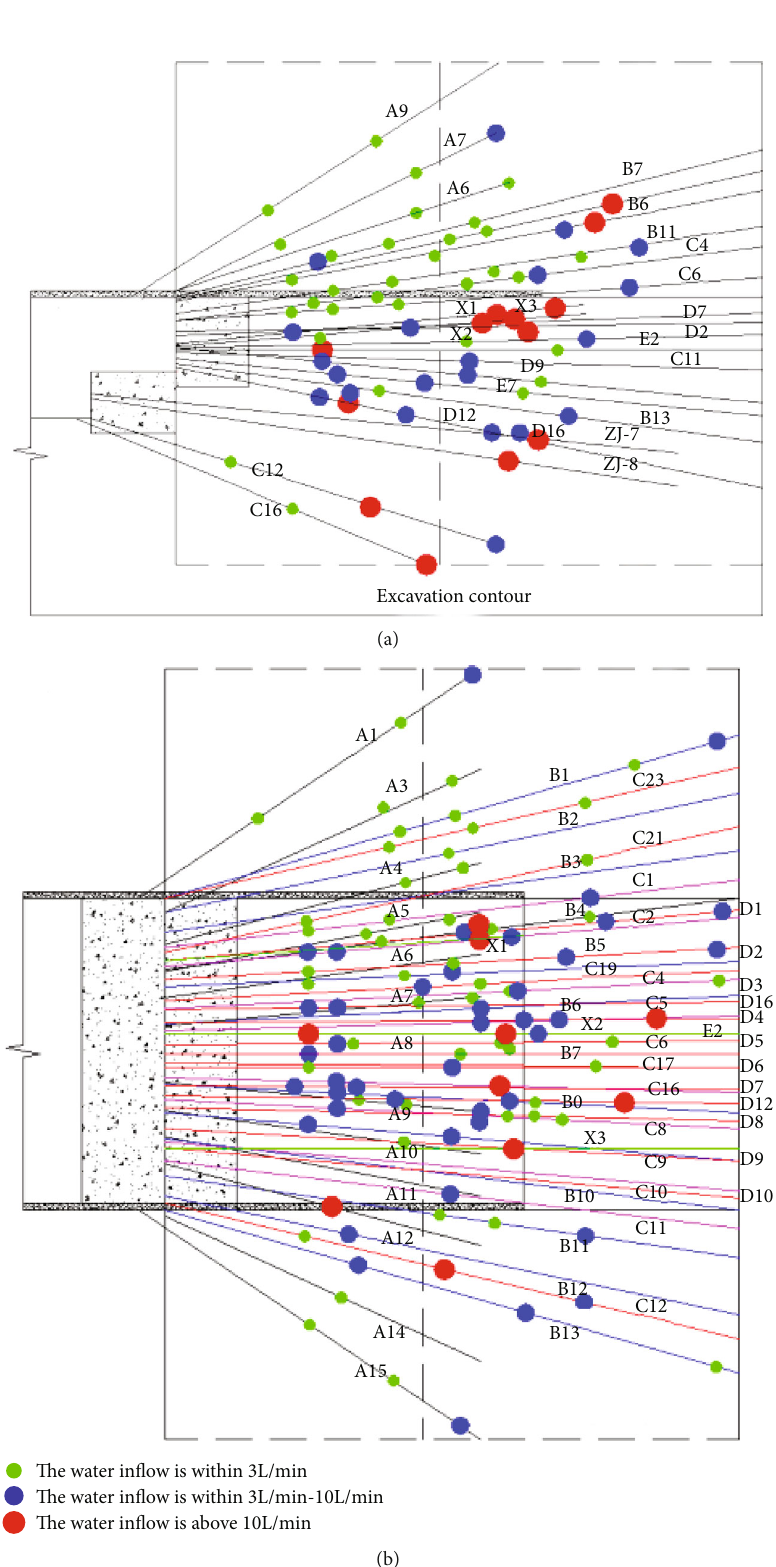
Figure 7: Detection results of some grouting holes: (a) elevation projection and (b) plane